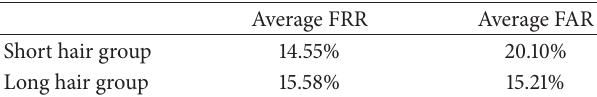
Table 4: Quantitative results of the algorithm without considering the hair style.